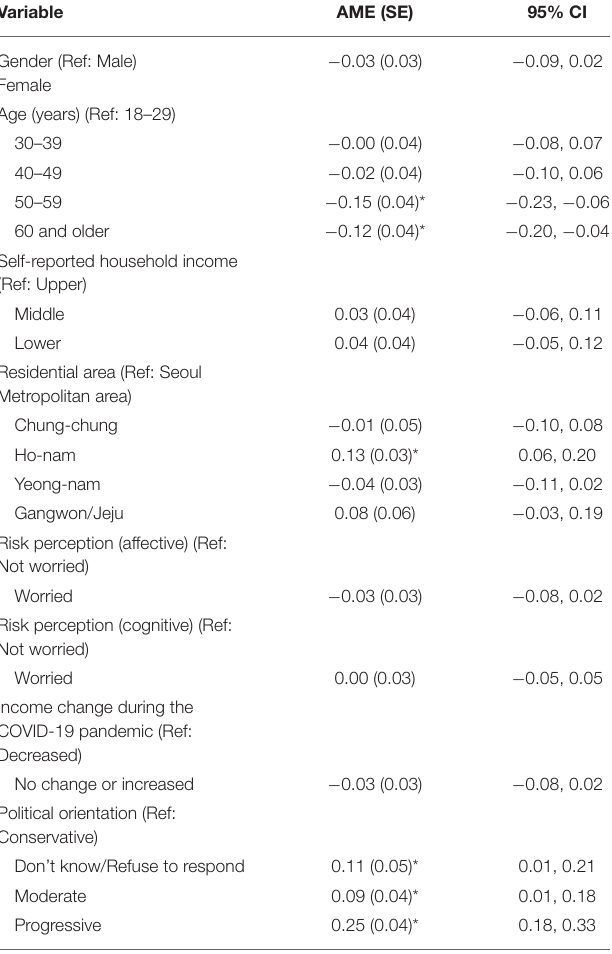
TABLE 2 | The average marginal effect of variables on attitude toward the cash transfer policy.